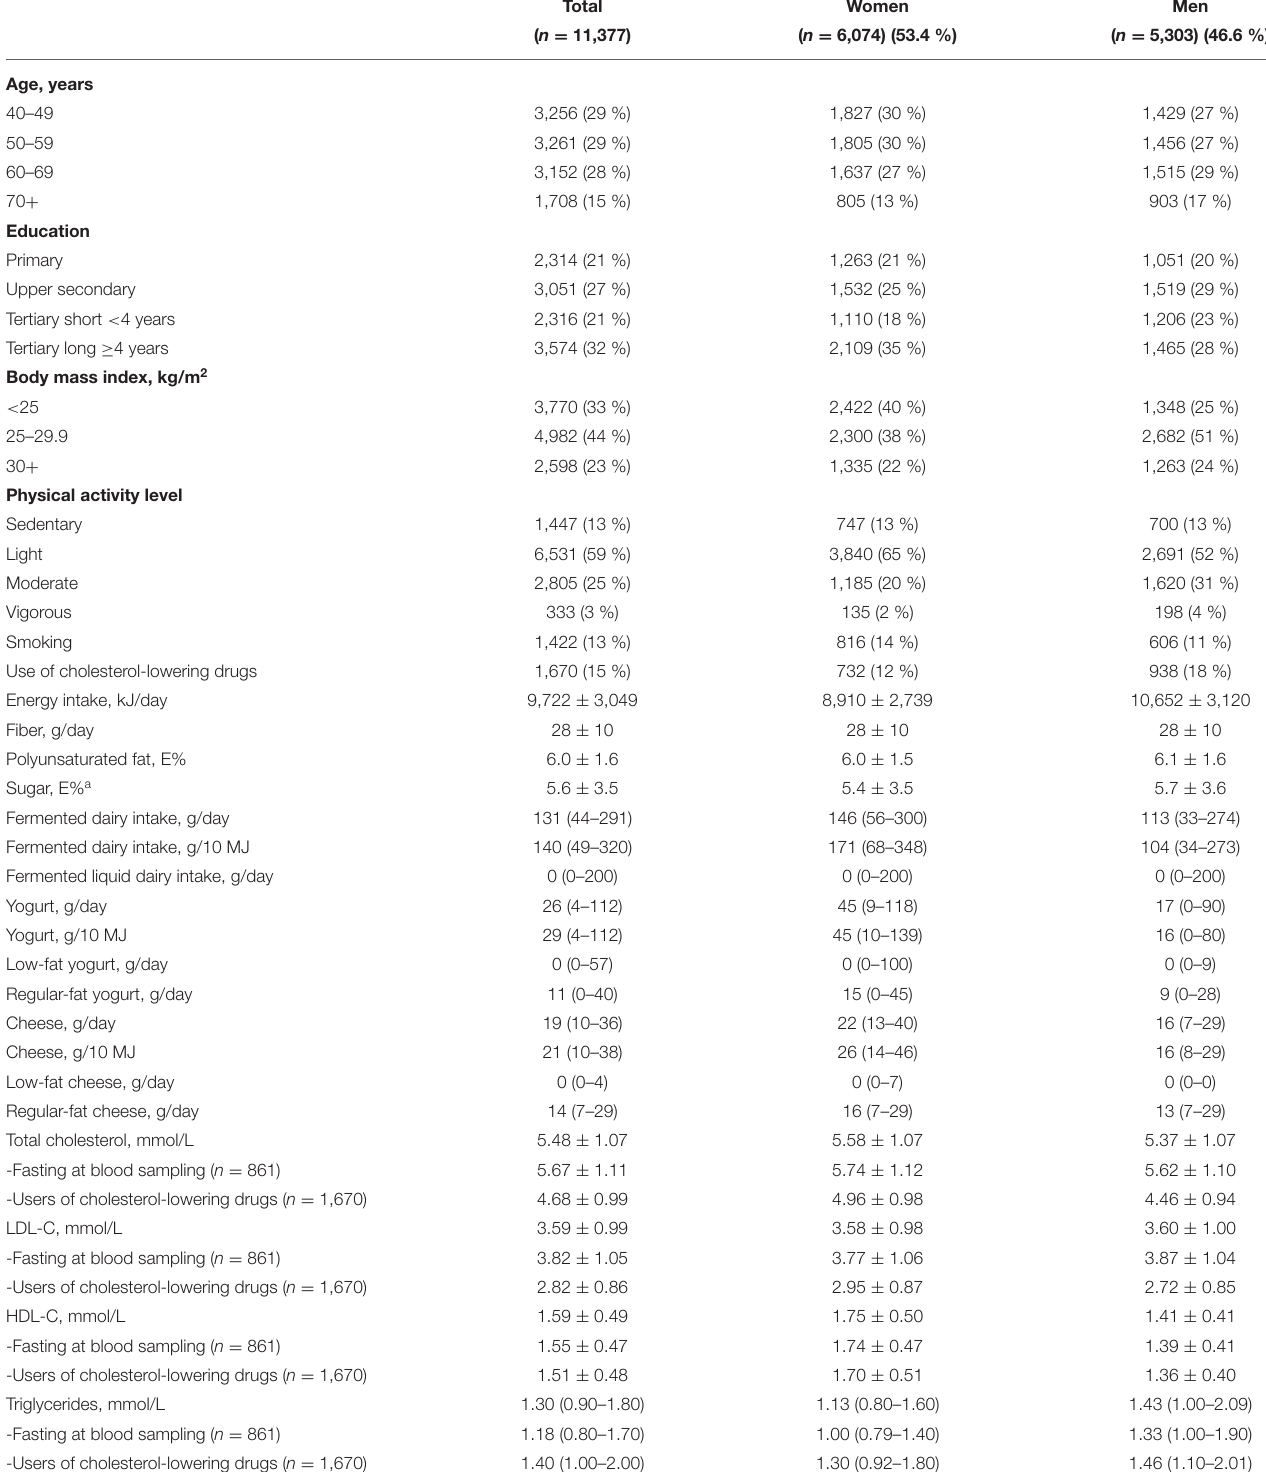
TABLE 1 | Characteristics of the study population. The Tromsø Study: